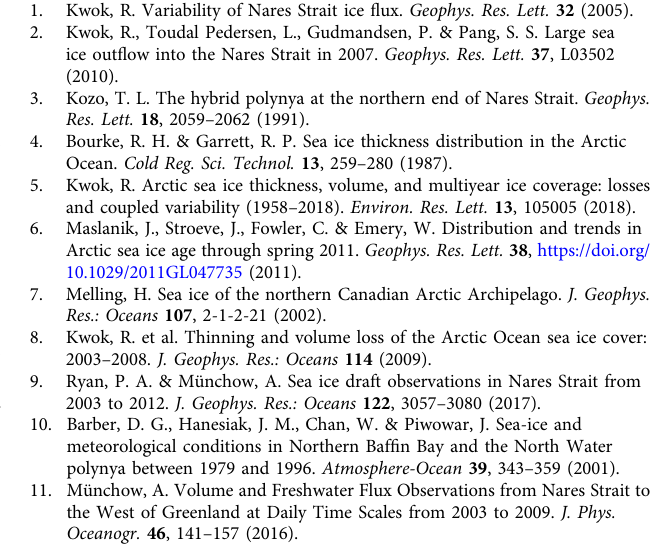
Data availability